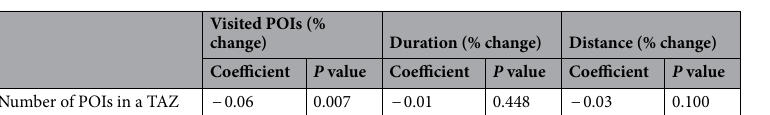
Table 4. Correlation analysis for the association between the number of POIs in a TAZ and access indicators.